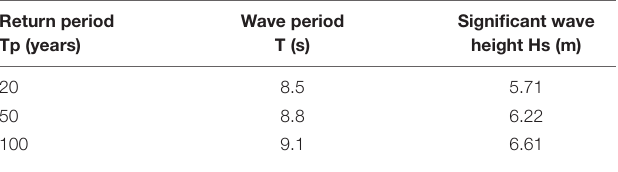
TABLE 1 | Extreme hydrodynamic wave parameters, after Boniecka et al.